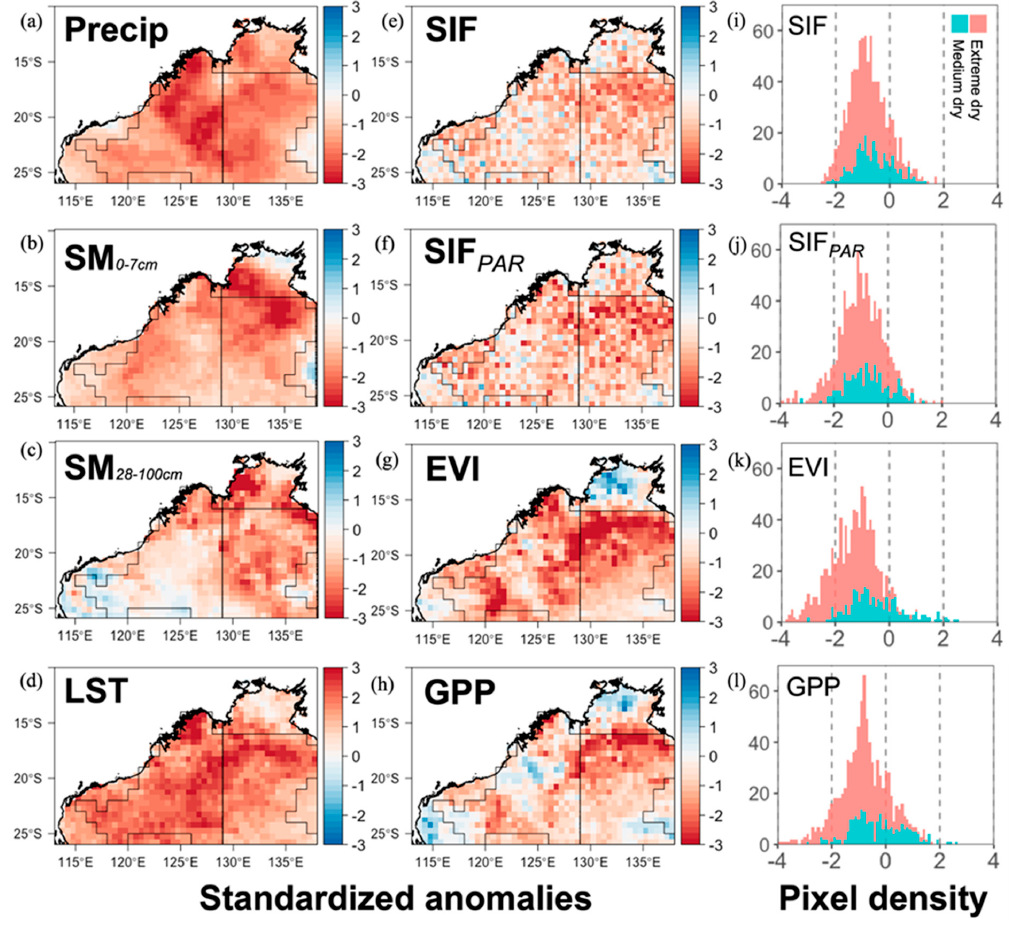
Figure 5. ( a – h ) Spatial distributions of the standardized anomalies of precipitation, surface/root zone soil moisture, LST, SIF, SIF PAR , EVI, and GPP during 2018–2019 monsoon season. ( i – l ) Pixel density of four vegetation variables within the extent of extreme and medium